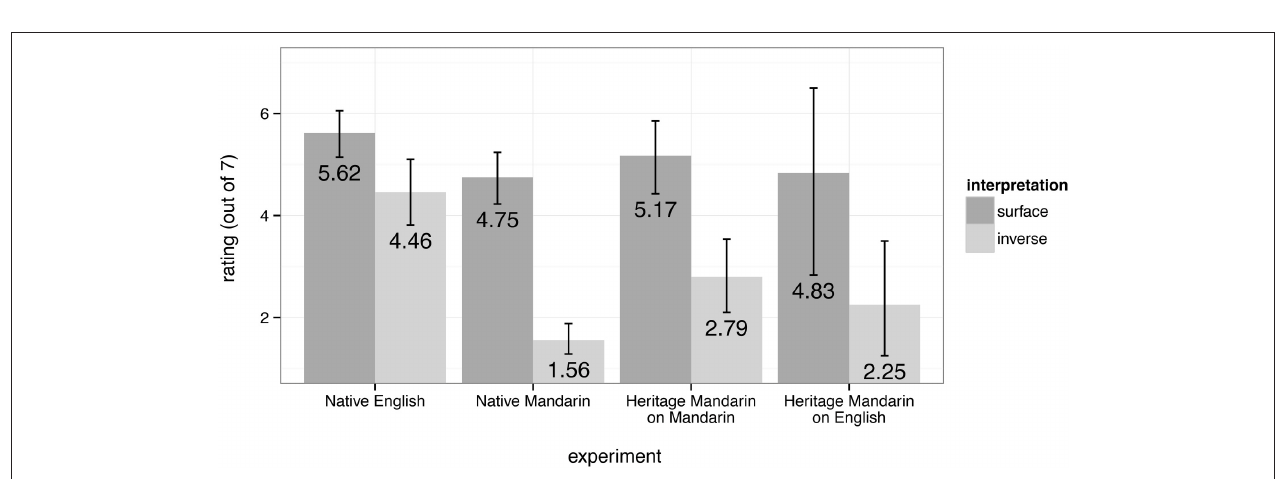
FIGURE 5 | Results from each of the four experiments from Scontras et al. (in press).